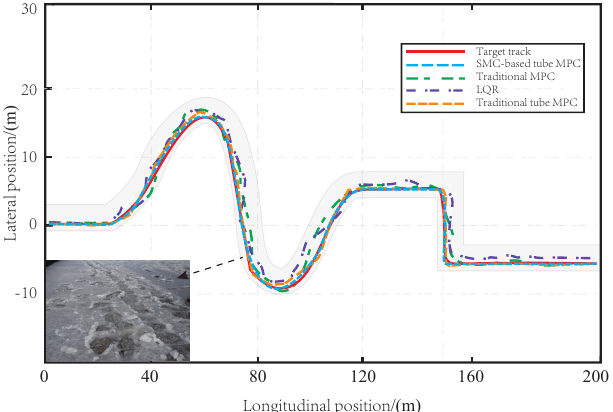
Figure 10. The path tracking effect on the icy road.